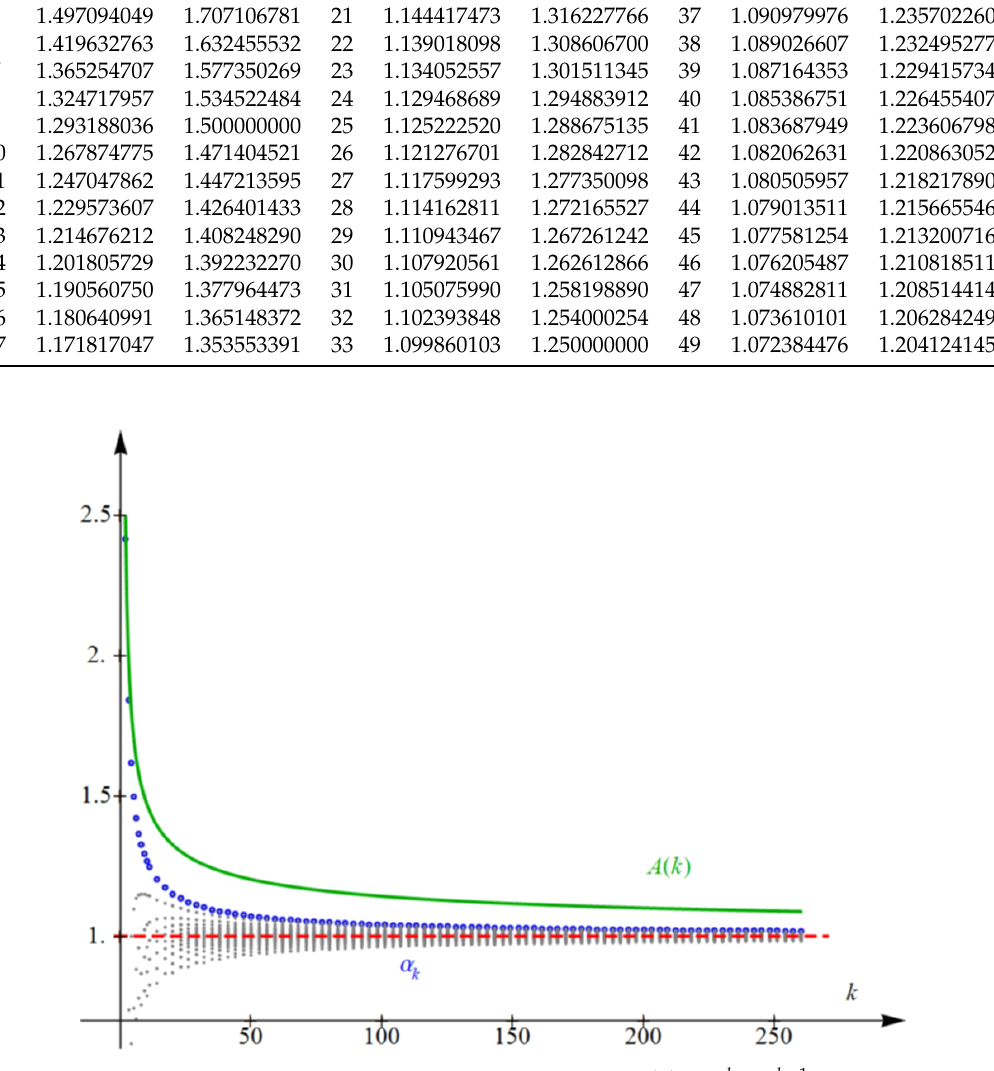
Figure 1. The graph of dominant roots α k (colored by blue) of f k ( x ) = x k − x k − 1 − x − 1, its upper (cid:112) bound A ( k ) = 1 + 2/ ( k − 1 ) (colored by green) and absolute value of the other roots of f k ( x ) (colored by gray) for k ∈ [ 2, 260 ]